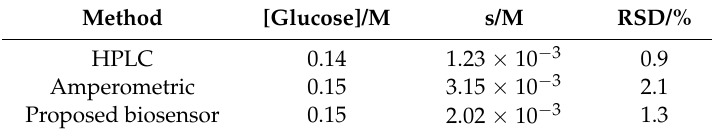
Table 1. Determination of glucose in a lemon soft drink using different analytical